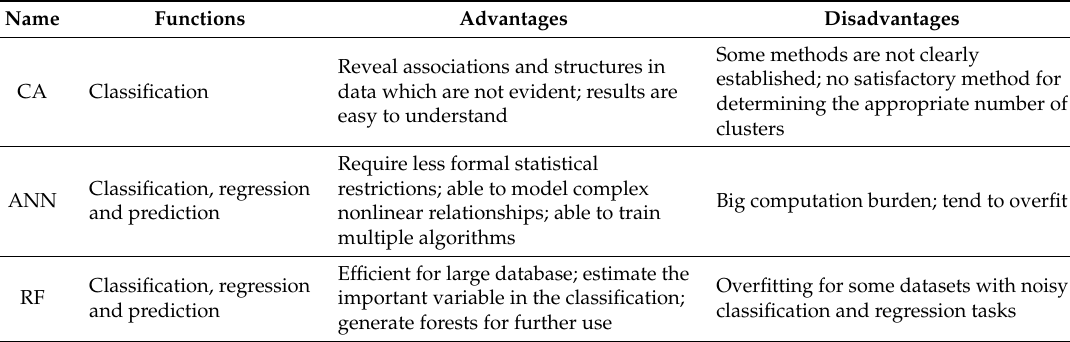
Table 3. Summary of advantages and disadvantages of CA, ANN and